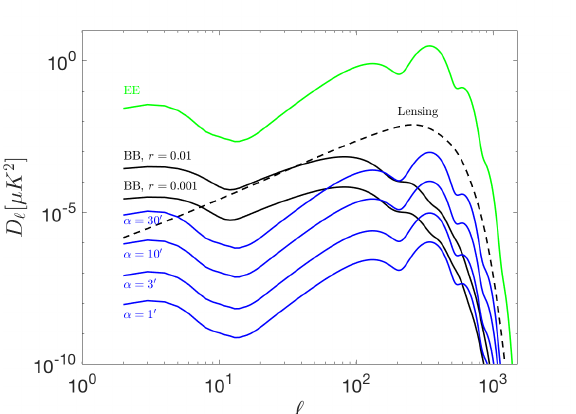
Figure 2. Systematic errors in the BB angular power spectra per logarithmic interval produced by polarization rotation. The spurious signal produced by 30, 10, 3 and 1 arc-minutes of rotation are represented by the blue curves. L2-CalSat would allow the suppression of any polarization angle errors to the region below the 1 arc-minute blue curve. Primordial B-mode for two values of r (solid black lines), gravitational lensing B-mode (dashed black) and the EE (solid green) spectra are plotted for reference. A Gaussian beam of FWHM = 30 arcmin has been adopted.